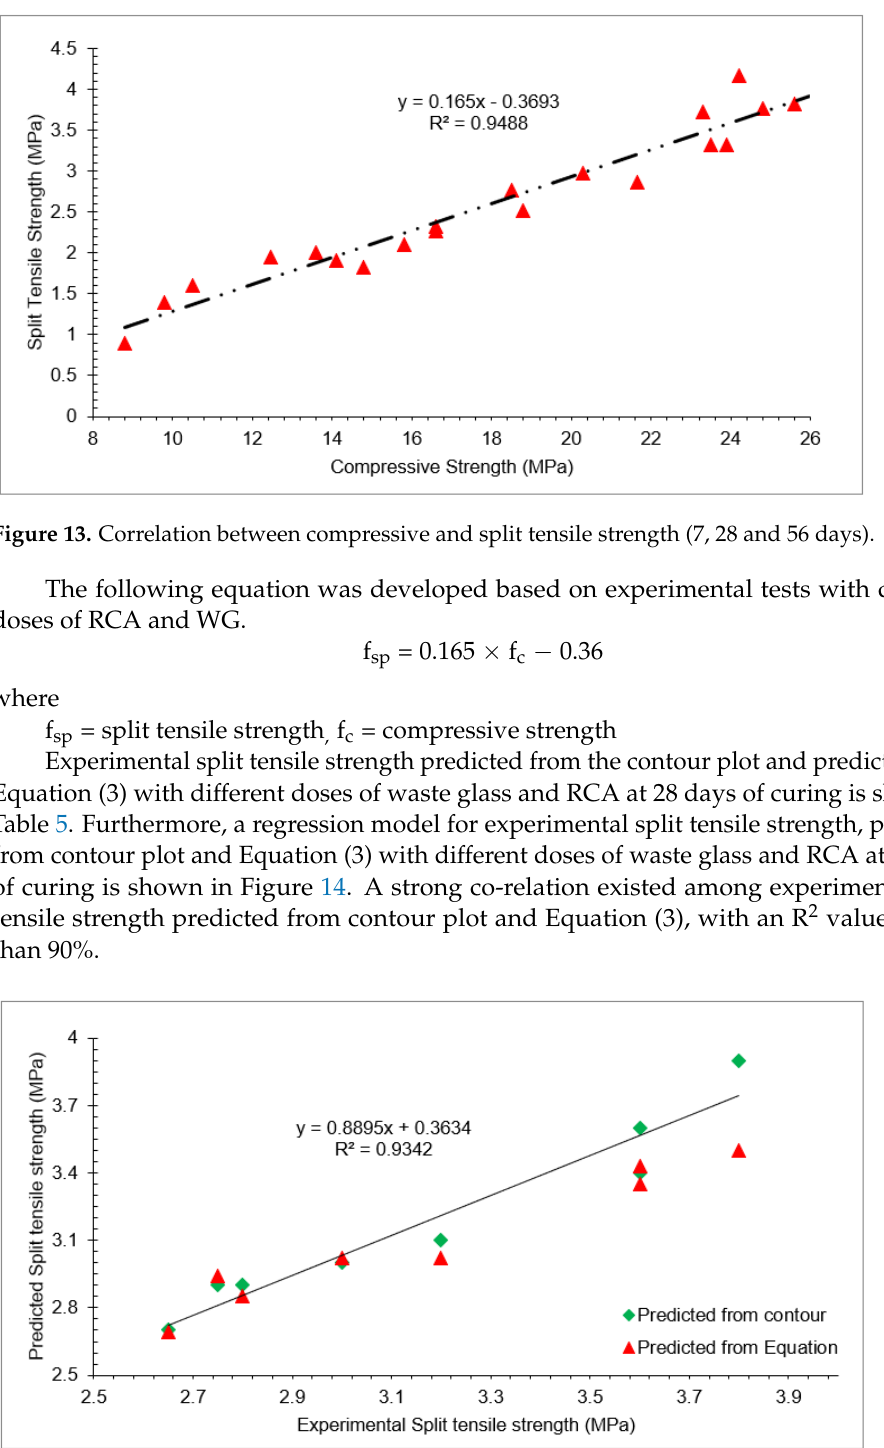
Figure 12. Contour plot of split tensile strength.